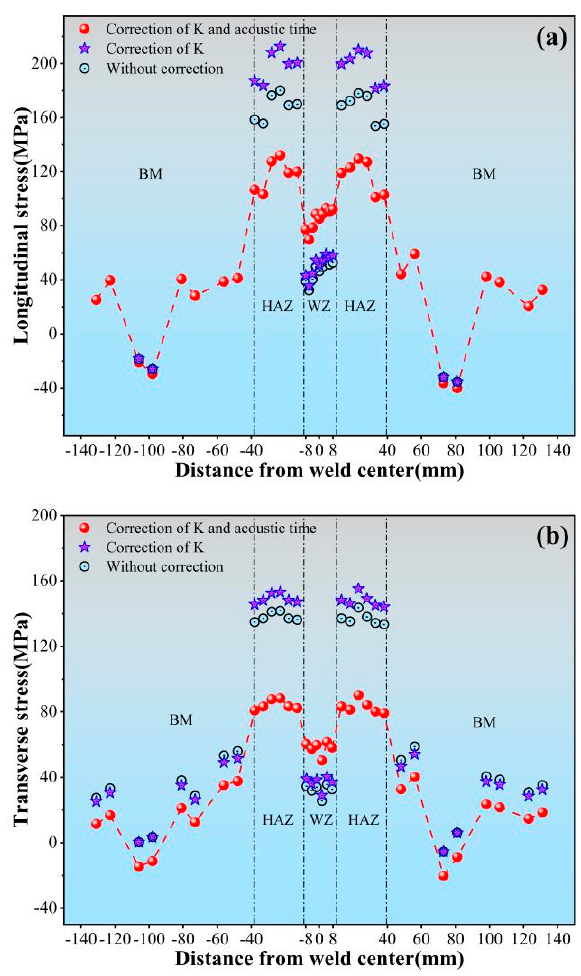
Figure 8. Comparison of ultrasonic test before and after correction ( a ) Longitudinal residual stress. ( b ) Transverse residual stress.